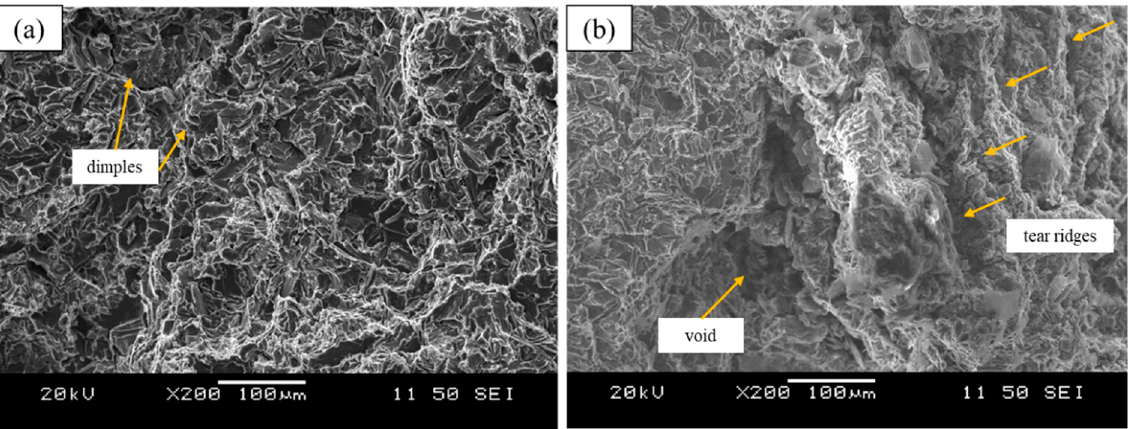
Figure 7. Fracture surface of ( a ) A319-0.05 GNP + SS + UST and ( b ) A319-0.1 GNP + SS